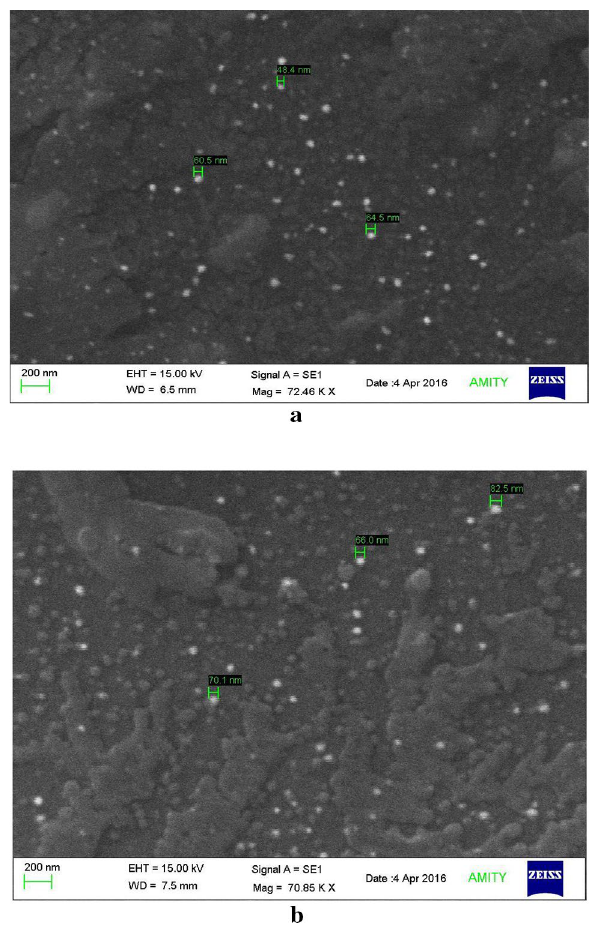
Figure 4. ( a ) SEM image of empty reconstituted virosome-SEM image depicts a reduction in particle size of reconstituted virosome (in white), with size ranging from 40 to 65 nm, due to the loss of membrane proteins and lipids; ( b ) SEM image of virosome with nanocurcumin sample shows circular morphology and size ranging from 60 to 90